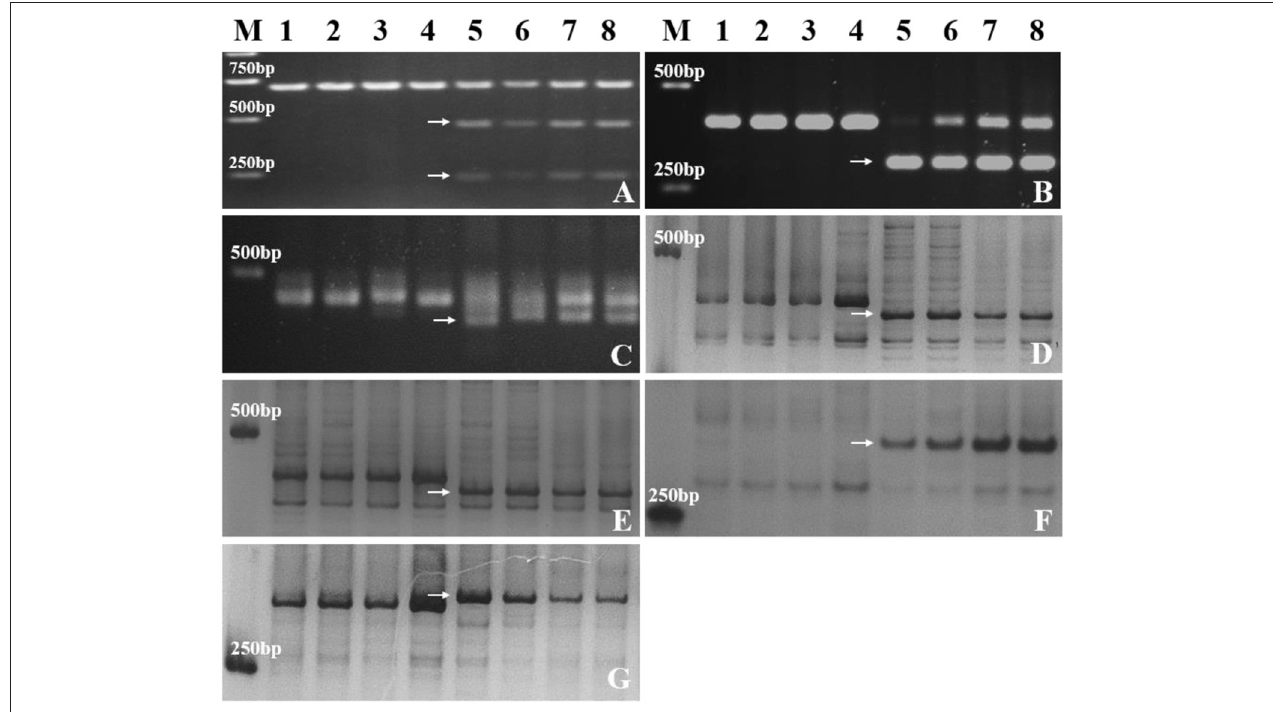
FIGURE 6 | Molecular markers analysis of SN0293-2, SN0293-7 and their parents. (A) CAPS421-HaeIII . (B) CAPS761-SacI . (C) CAPS564-BstEII . (D) Indel192 . (E) Indel101 . (F) Indel752 . (G) Indel753 . Lanes: M, DL2000 marker; 1–8 refer to SNF63, YN15, SN224, JM22, Th. ponticum , SNTE20, SN0293-2, and SN0293-7, respectively. Arrows indicate specific bands of Th. ponticum .